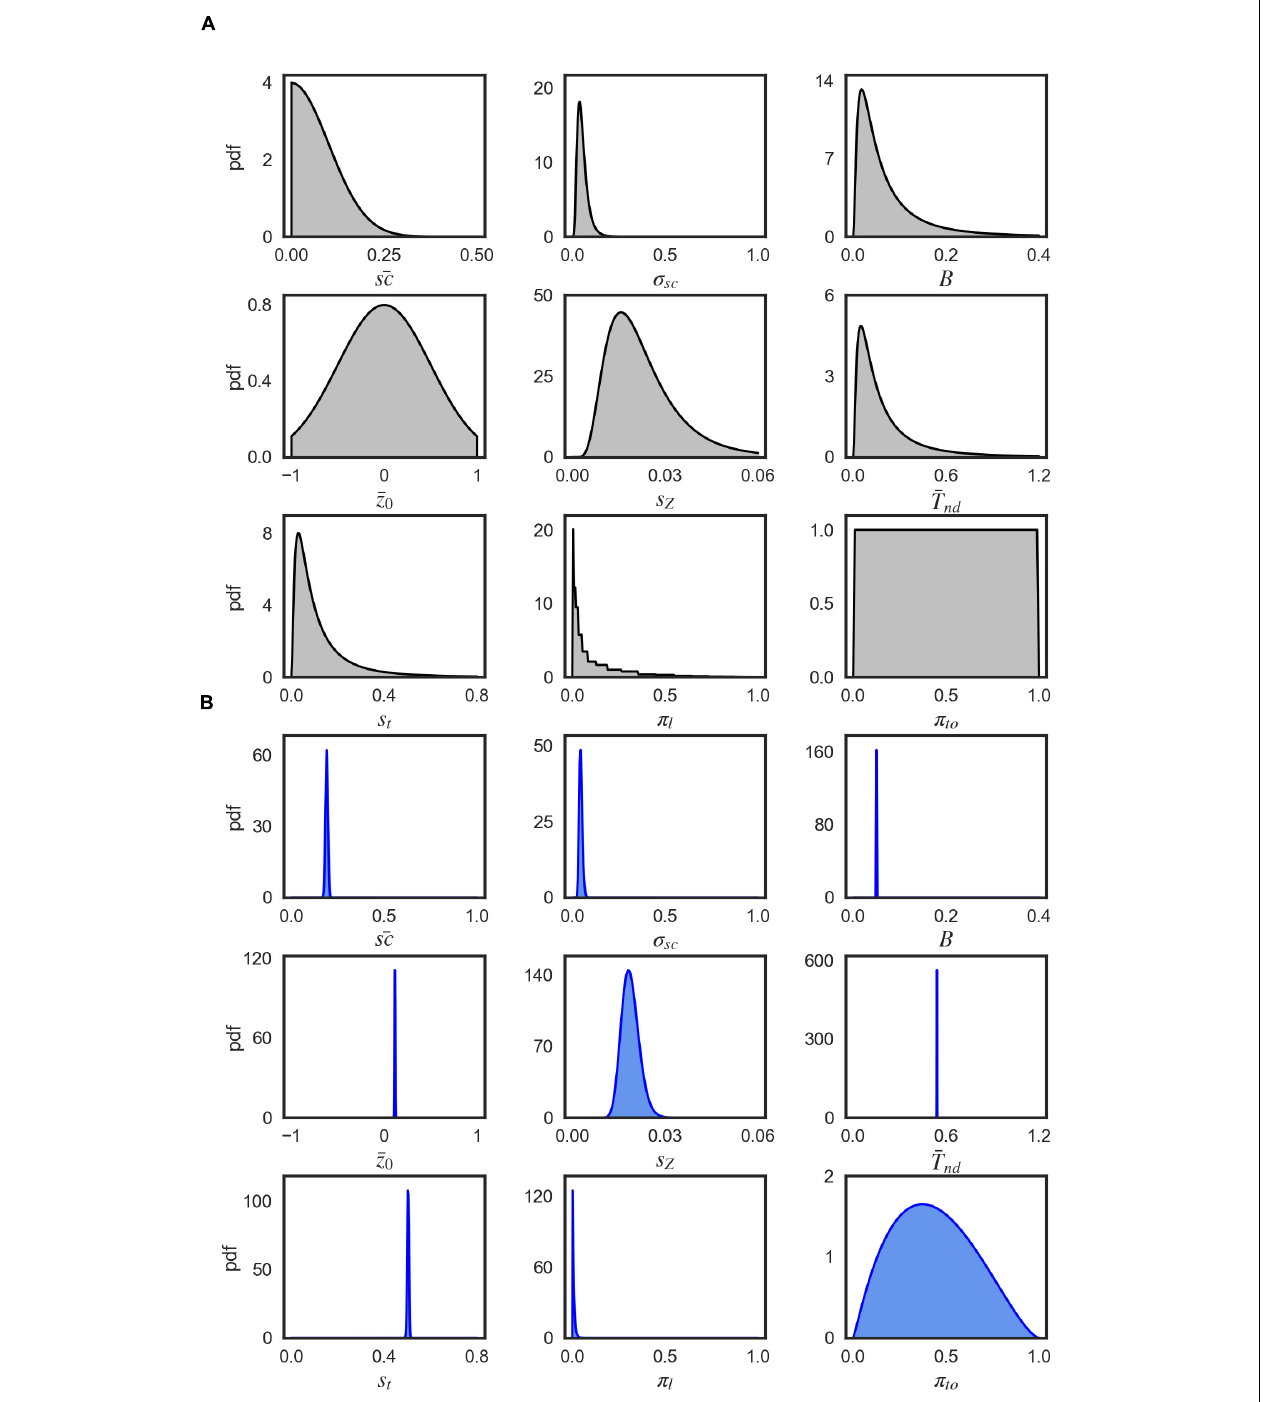
FIGURE 9 | Visualization of parameter distributions. (A) Prior densities for each parameter in Table 3 , (B) Example (marginal) posterior parameter densities of the EXM for participant 44, 0% coherence level.